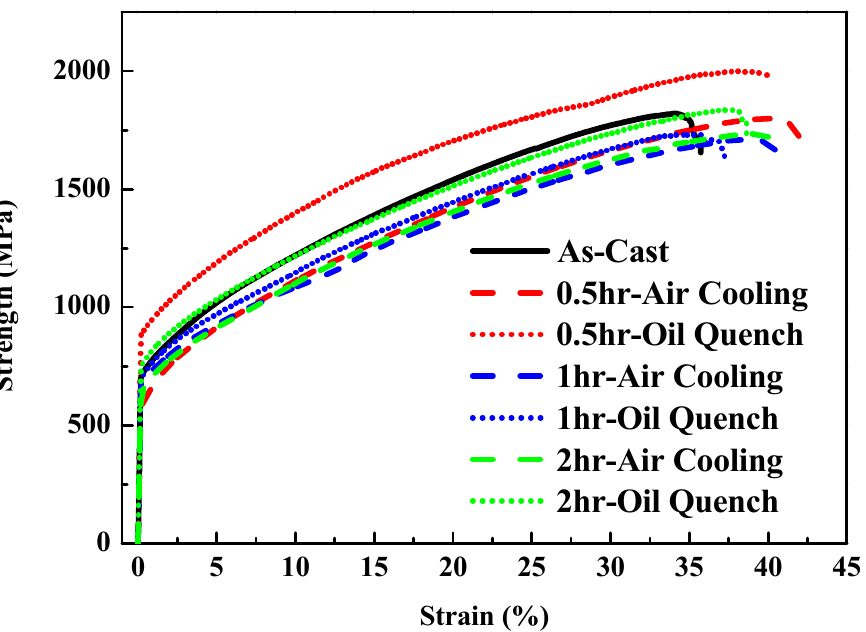
Table 4. The oil-quenching process significantly improved the compressive strength of the MEAs through fraction evolution and the morphology of the BCC phase, as presented in Figure 13. The oil-quenching process induced higher strength in the MEAs compared with the air-cooling process. It supposed that the increase of BCC fraction which was attributed to rapid cooling rates led to increase in strength. However, with increased annealing time, the phase morphology become more rounded and the strength decreased slightly. For improving the mechanical properties through manipulation of phase morphology, the quenching approach was more effective than annealing time in this study.